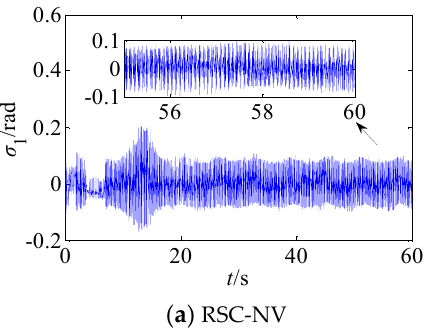
Figure 6. Elastic vibration curve of joint O 1 .